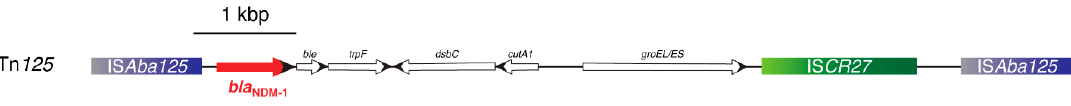
Figure 3. Genetic map of A. baumannii transposon Tn 125 . Figure interpreted from Poirel et al.